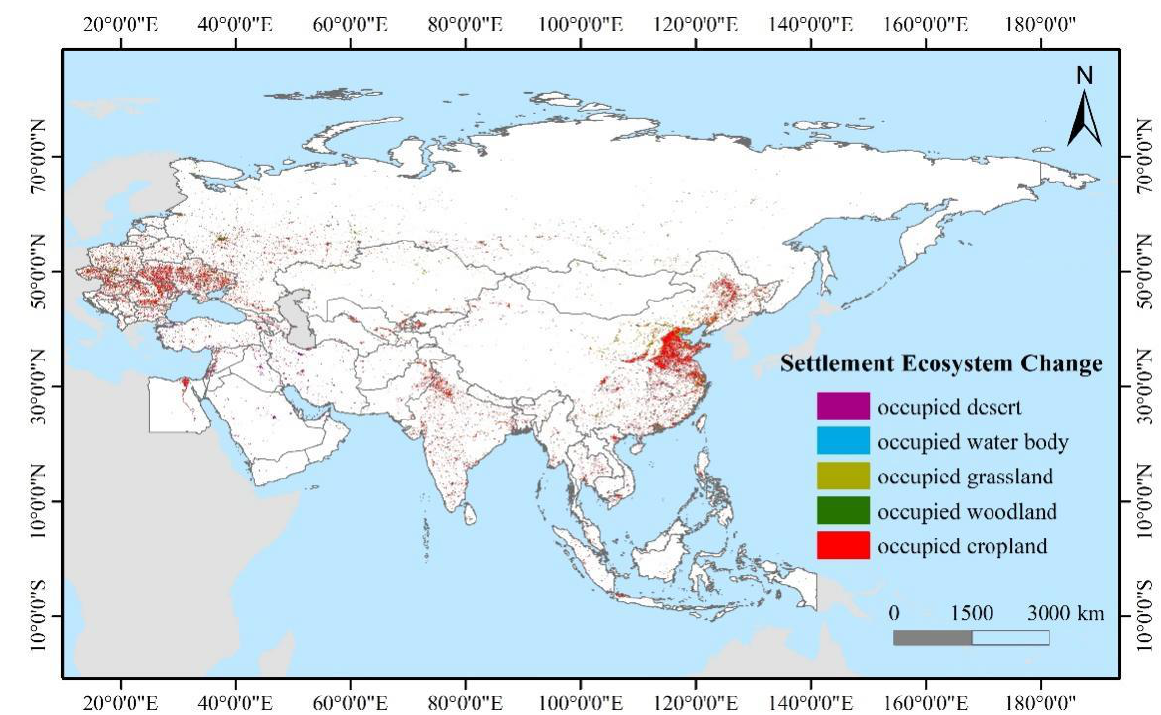
Figure 10. Spatial distribution of settlement ecosystem changes in the Pan-Third Pole region from 2000 to 2020.